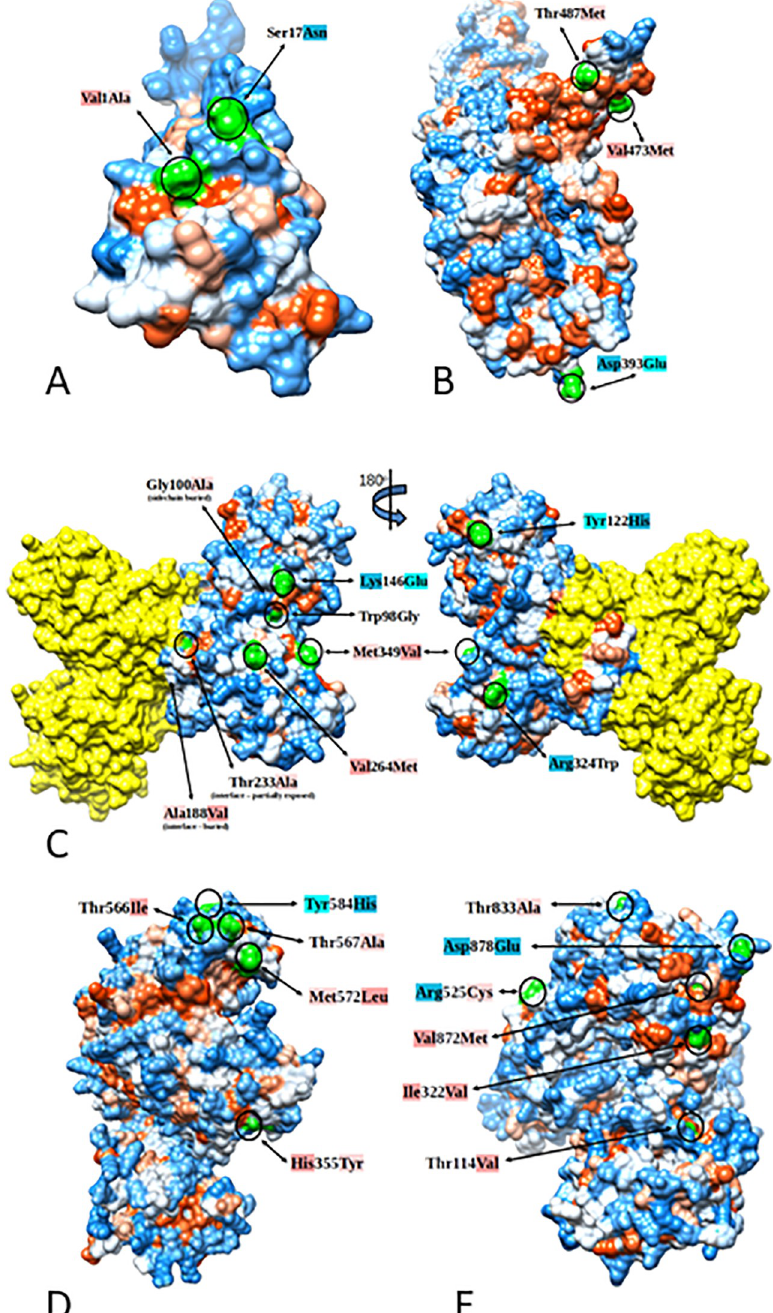
Fig 4. Epidemic-associated mutations tend to occur in exposed regions of Zika proteins. Protein “hydrophobicity surface” representation of Zika proteins Pr, E, NS1, NS3, and NS5 using Kyte-Doolittle scale [47] and the coloring scheme from blue (hydrophilic) to red (hydrophobic), with white color representing neutral residues. For a given mutation, a difference in hydrophobicity score between initial residue and the mutation is indicated by a change in the color intensity used as text background. For example, light red for lower and dark red for higher hydrophobicity, and light blue for lower and dark blue for higher hydrophilicity. Exposed regions of listed mutations are circled and colored in green. Plots were constructed using Chimera software. (A) Model of the Pr protein with epidemic mutations first detected in 2013: Val1Ala, Ser17Asn. (B) E protein with high abundance epidemic mutation Val473Met (observed in 387 sequences; see Table 1) first detected in 2013, and two mutations, Asp393Glu and Thr487Met, first observed in pre-emergent samples from Thailand in 2006, Cambodia in 2010, Philippines in 2012 and French Polynesia in